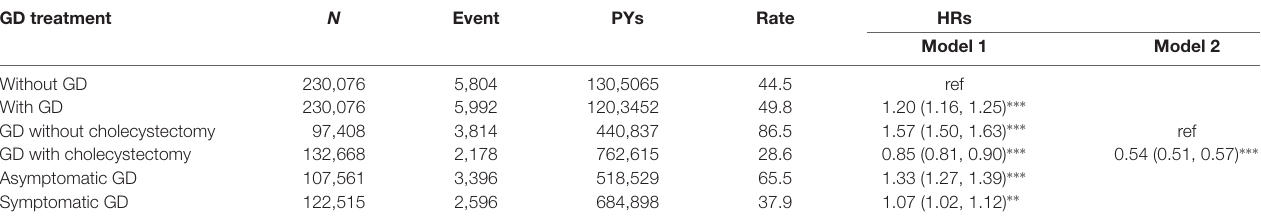
TABLE 2 | Incidence and HRs of AF in GD and control groups.